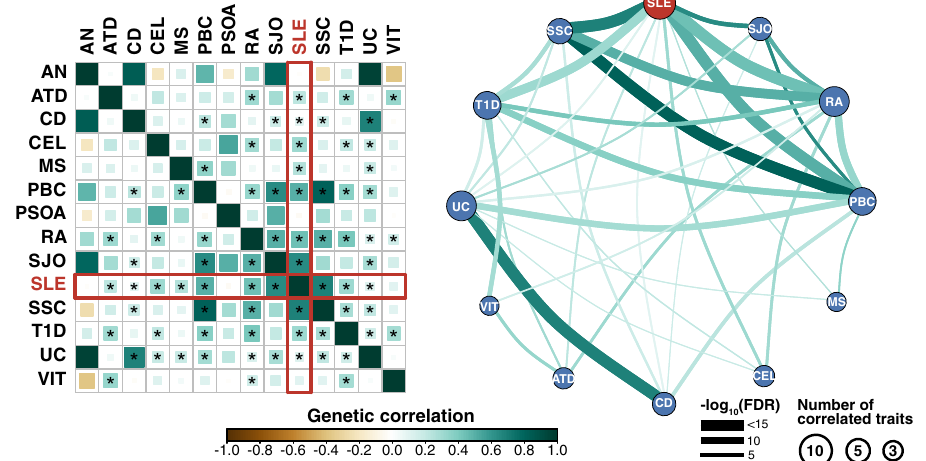
Fig. 1 | Genetic correlations across 14 autoimmune diseases in European ancestry. Leftpanelindicatesgeneticcorrelationsacross14autoimmunediseases. Genetic correlation is estimated using cross-trait LDSC. Color intensity and size of square are proportional to strength of genetic correlation (brown = negative cor- relation, green = positive correlation). Asterisks indicate genetic correlations that are statistically signi fi cant at false discovery rate level of 0.05. Red boxes highlight the correlation betweenSLE and othertraits. Right panel illustrates the network of signi fi cantly genetically-correlated traits. The colors of the lines represent the